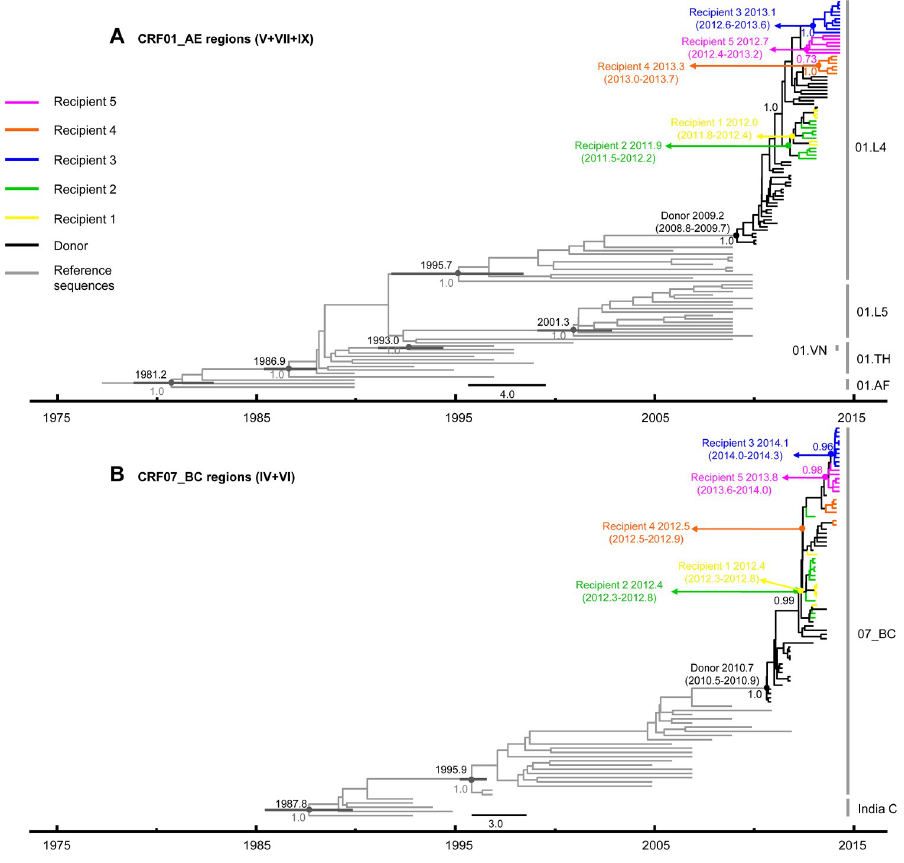
Fig 4. Maximum clade credibility (MCC) trees of HIV-1 CRF01_AE/CRF07_BC recombinants from the donor and five putative recipients. Some representative sequences of the donor, all sequences of five recipients and references were selected to constructed MCC trees. Bayesian molecular clock analysis were performed using BEAST v2.5.1 for concatenated CRF01_AE segments (Regions V+VII + IX) (A) and CRF07_BC segments (Regions